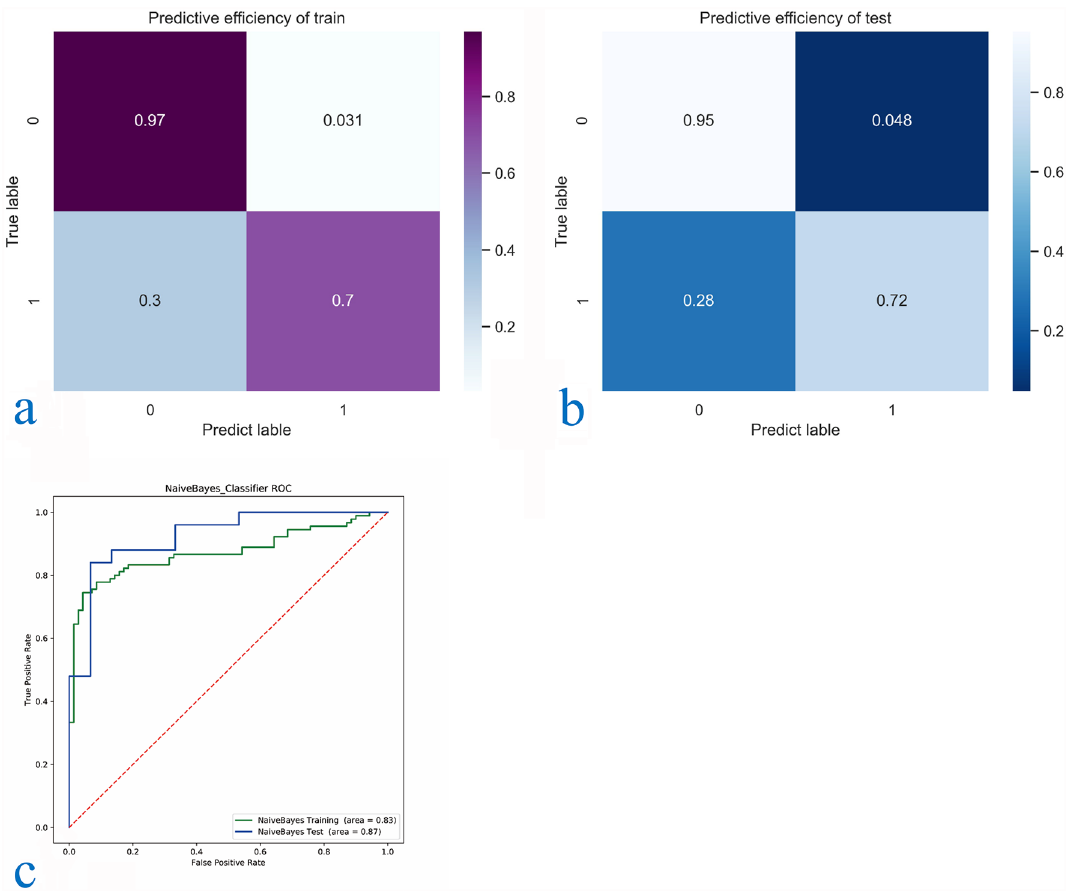
Figure 8. ( a – c ) Confusion matrix and ROC curve of classification results of the training group and test group of naive Bayesian